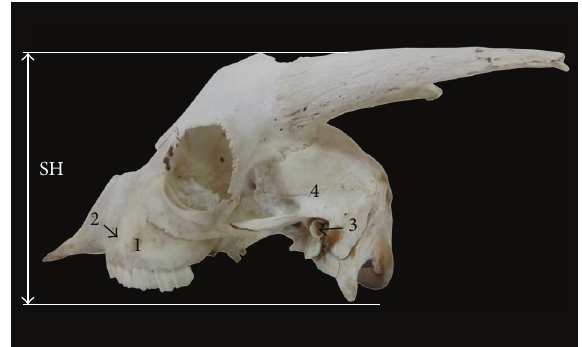
Figure 2: Lateral view of the skull of Markhoz goat showing SH: skull height. 1: facial tuberosity, 2: infraorbital foramen, 3: external auditory meatus, and 4: temporal fossa.